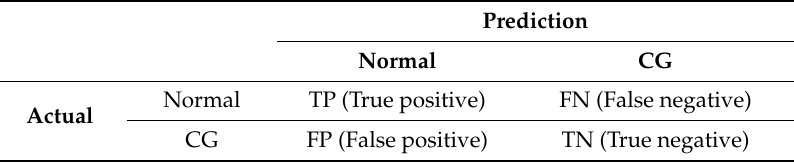
Table 2. A confusion matrix for summarizing the classification